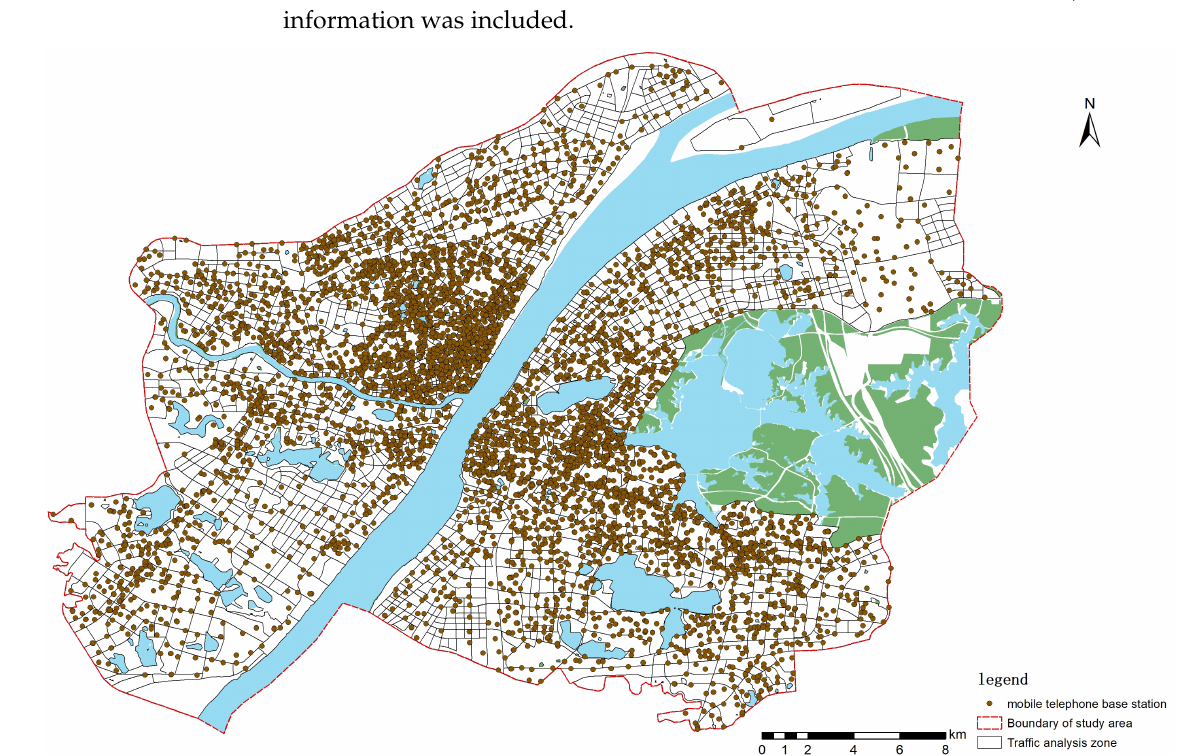
Figure 4. Base station location